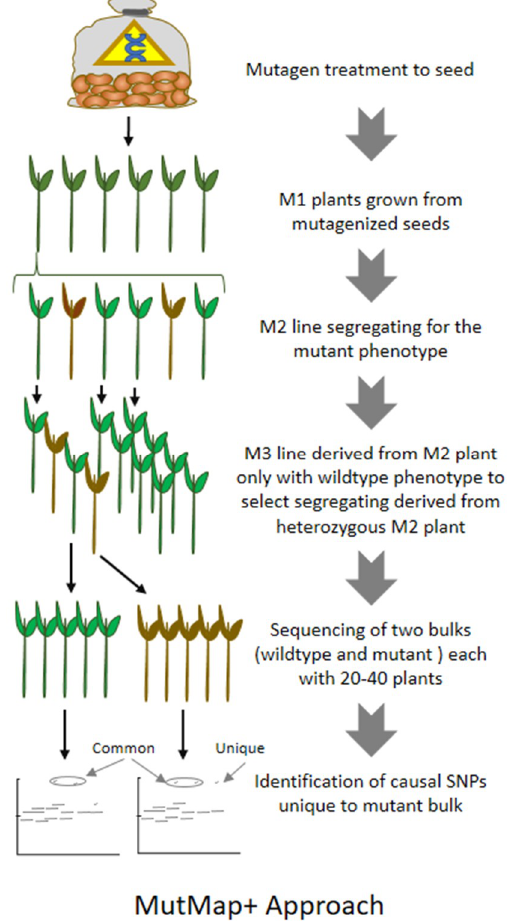
Figure 3. Schematic representation of MutMap + strategy exploring next-generation sequencing for identification of casual SNP unique to bulk mutant.